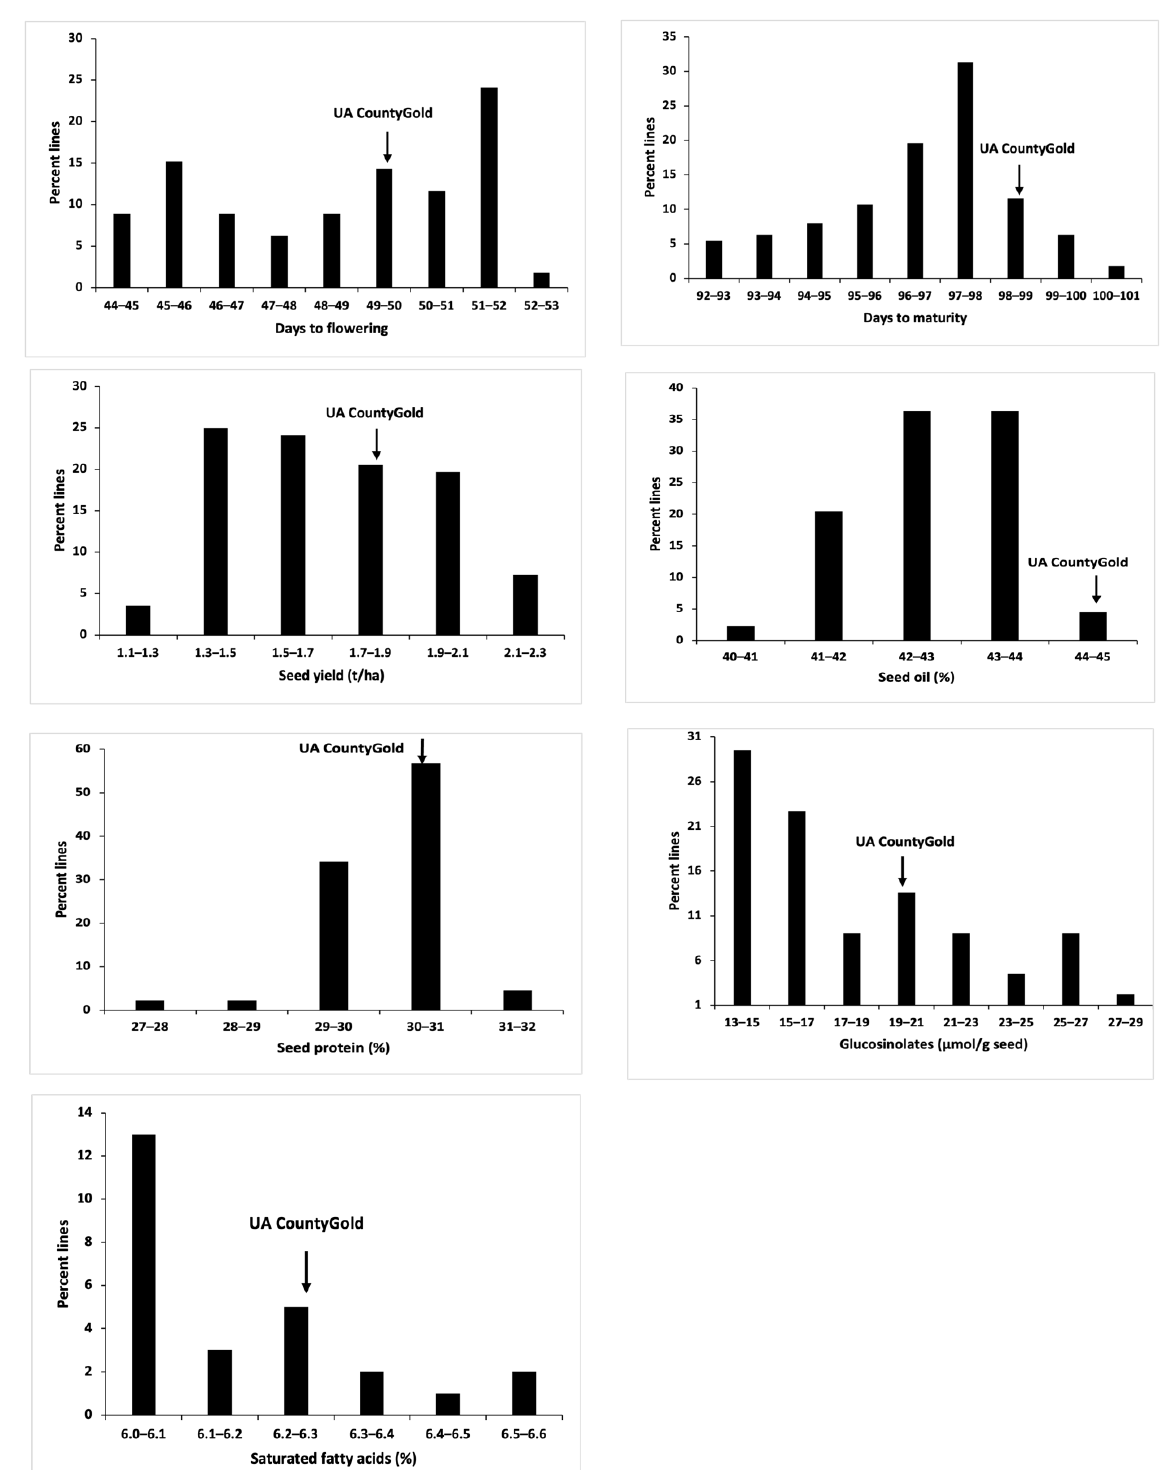
Figure 3. Distribution of the BC 1 F 9 lines of the ( B. napus × B. rapa ) × B. napus interspecific cross grown in replicated field trials in 2021, for days to flowering ( n = 112 lines), days to maturity ( n = 112), and seed yield ( n = 112), and seed oil ( n = 44), protein ( n = 44), glucosinolate ( n = 44), and saturated fatty acids ( n = 44). The value for the check cultivar UA CountyGold is indicated by the vertical arrow.